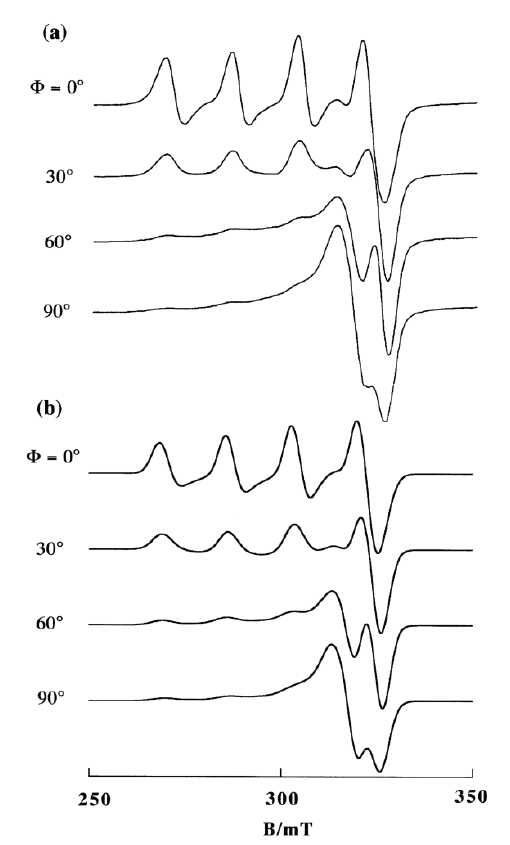
Figure 8. Observed ( a ) and calculated ( b ) EPR spectra of [Cu(phen)(Lys)] 2+ on B-form DNA fibers at room temperature. [DNA-bp]/[Cu(II)] = 30, species I : g || = 2.23, g ⊥ = 2.07, = 0.0015 cm − 1 , A N || = 0.0010 cm − 1 , (cid:1827) = 0.0010 cm − 1 , θ = 3°, A || = 0.0177 cm − 1 , (cid:1827) (cid:2884) (cid:3015)(cid:2884) Δθ = 15°, Δ B || = 25 G, Δ (cid:1828) = 30 G. Species G : g || = 2.235, g ⊥ = 2.07, A || = 0.0172 cm − 1 , (cid:2884) = 0.0013 cm − 1 , A N || = 0.0010 cm − 1 , (cid:1827) = 0.0010 cm − 1 , θ = 30°, Δθ = 30°, Δ B || = 45 G, (cid:1827) (cid:2884) (cid:3015)(cid:2884) Δ (cid:1828) = 45 G. [ G ]/[ I ] = 2 (cid:2884)